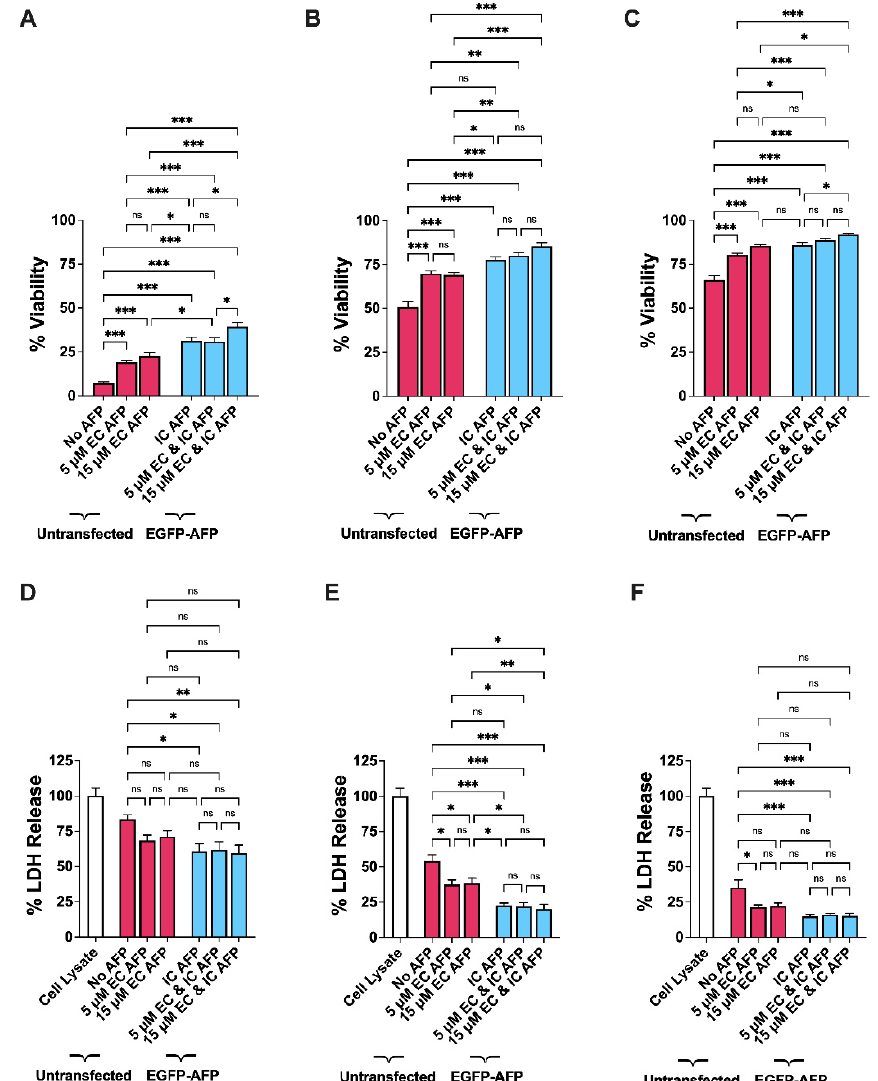
Figure 5. ( A – C ) Trypan blue exclusion assay in untransfected (red bar graphs) and AFP-transfected (IC AFP, blue bar graphs) HEK 293T cells after cryopreservation. A total of 5 × 10 6 cells were cryopreserved with ( A ) 0, ( B ) 5, and ( C ) 10% ( v / v ) concentrations of DMSO and/or 5 or 15 µ M (0.132 or 0.396 mg/mL) TrxA-ApAFP752 (EC AFP) and stored in liquid nitrogen vapor phase ( − 196 ◦ C) for ≥ 4 weeks. ( D – F ) LDH assay measurement of cell damage for untransfected (red bar graphs) and AFP-transfected (IC AFP, blue bar graphs) HEK 293T cells after cryopreservation. A total of 5 × 10 6 cells were cryopreserved with ( D ) 0, ( E ) 5, and ( F ) 10 % ( v / v ) concentrations of DMSO and/or 5 or 15 µ M (0.132 or 0.396 mg/mL) TrxA-ApAFP752 (EC AFP) and stored in liquid nitrogen vapor phase ( − 196 ◦ C) for ≥ 4 weeks. All values are media subtracted and cell damage is expressed as % total cellular LDH in cell lysate (white bar graph). Data were analyzed using a one-way analysis of variance (ANOVA) and Tukey’s post hoc test was used for pairwise comparisons of experimental groups. All experiments contained 3 biological repeats ( n = 3), with each containing 3 technical repeats. Mean value ± SEM (n.s. p > 0.05, * p ≤ 0.05, ** p ≤ 0.01, *** p ≤ 0.001). Post-thaw cell damage was measured using an LDH assay comparing untransfected cells to the various AFP treatments (Figure 5D–F). For 5 µ M vs. 15 µ M EC AFP,